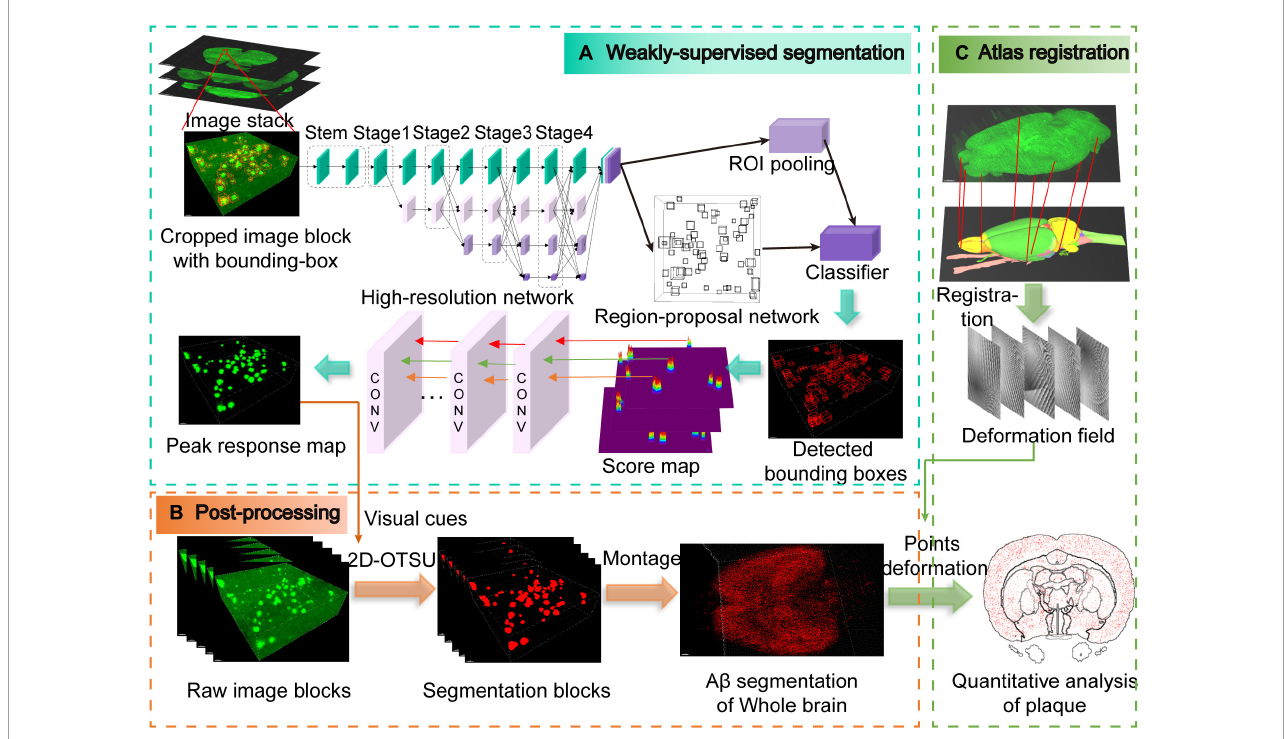
FIGURE2 Schematic illustration of the entire analysis pipeline. (A) Weakly supervised segmentation with the high-resolution network. The pipeline is modified from the Faster-RCNN framework, and the peak response mapping method is embedded in our framework for extracting additional visual cues for subsequent segmentation. Note that only weak labels (bounding boxes) are required in our pipeline, which are shown as red boxes in the cropped image block. (B) Post-processing for obtaining whole-brain A β segmentation masks. (C) Obtaining the deformation field from the atlas registration process and then utilizing it to the segmentation masks from panel (B) for quantitative analysis of whole-brain